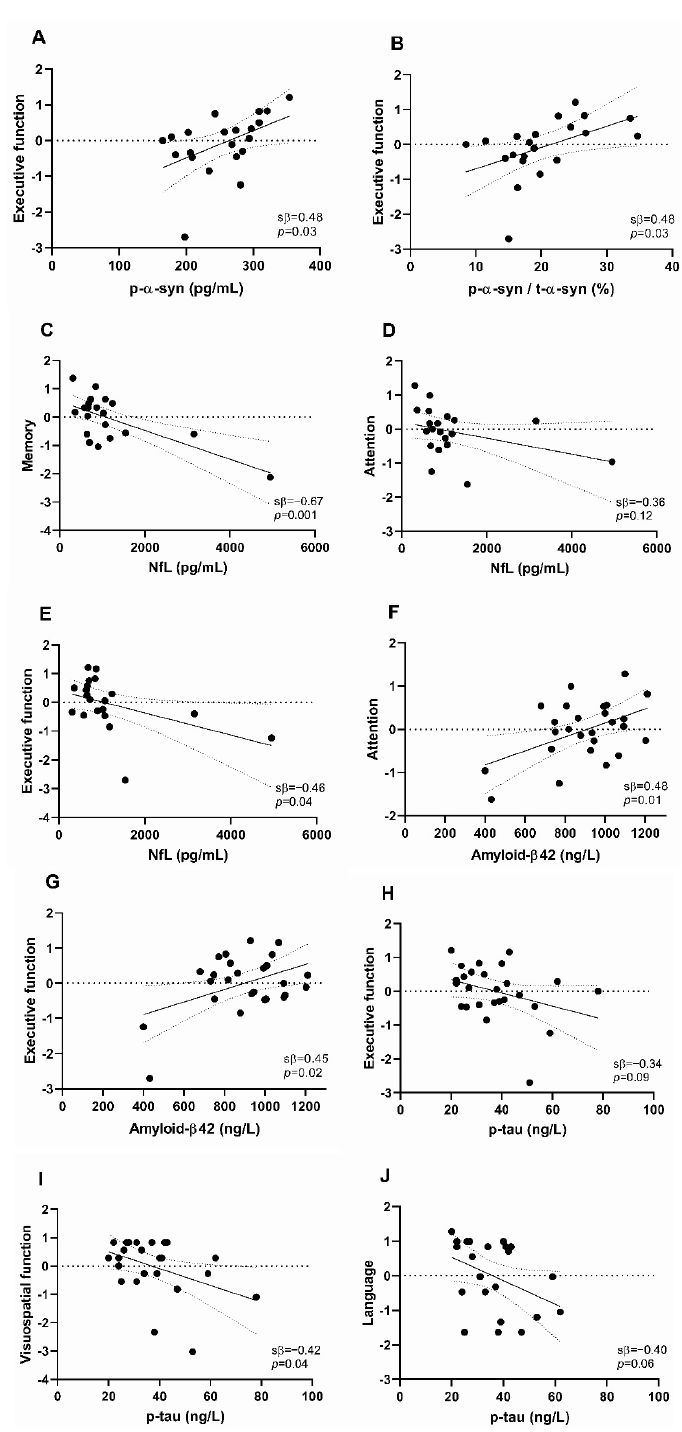
Figure 2. Scatter plots illustrating the relatively strongest associations of cerebrospinal fluid (CSF) biomarker levels with cognitive domain scores in early-stage Parkinson ′ s disease patients. Associations between ( A ) CSF p- α -syn and executive functioning, ( B ) CSF p- α -syn/t- α -syn ratio and executive functioning, ( C ) CSF NfL and memory, ( D ) CSF NfL and attention, ( E ) CSF NfL and executive function, ( F ) CSF amyloid- β 42 and attention, ( G ) CSF amyloid- β 42 and executive function, ( H ) CSF p-tau and executive function, ( I ) CSF p-tau and visuospatial function, ( J ) CSF p-tau and language. Data are standardized regression coefficients from univariable linear regression models. A solid line indicates a linear regression, while dotted lines have 95% confidence intervals. Each dot in the scatter plot represents a subject. Abbreviations: CSF, cerebrospinal fluid. p- α -syn, phosphorylated α -synuclein. t- α -syn, total α -syn. NfL, neurofilament light chain. p-tau, phosphorylated tau. s β , standardized β -coefficient.